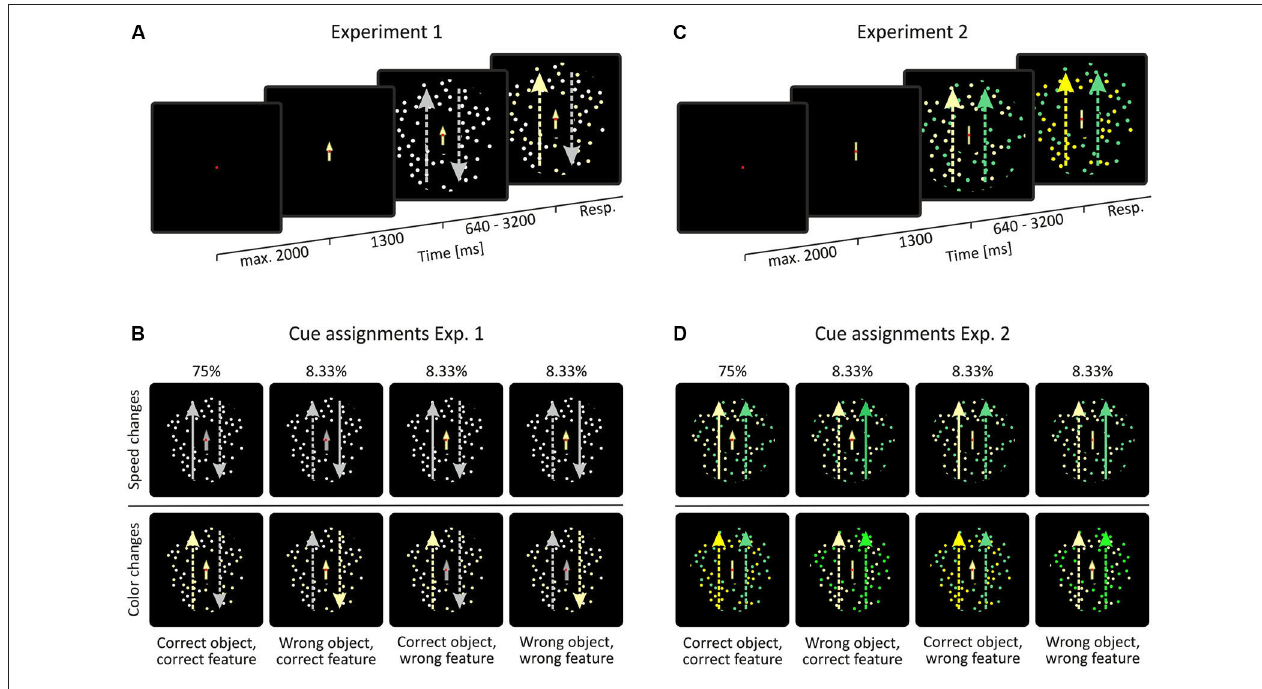
lateral arrows represent the features of the RDPs: arrow direction indicate RDP motion direction, dotted lines indicate normal speed, straight lines indicate increased speed, and arrow color indicates RDP color. These arrows are shown for illustration purposes only and were not part of the display. Note that stimulus colors were chosen for illustration purposes only. Actual colors used in the experiment were slightly different and color changes were less obvious as compared to the